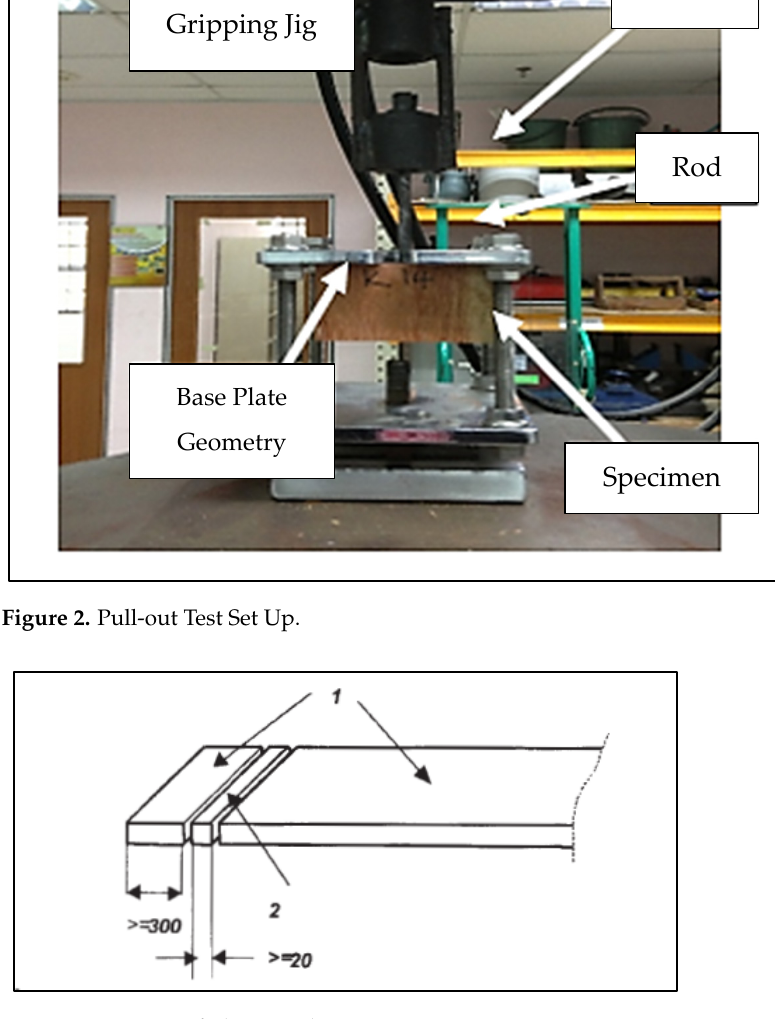
Figure 3. Position of The Test Slice.